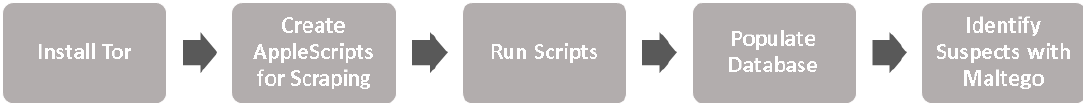
Figure 1. Framework for automated and more accessible Dark Web market place investigations.